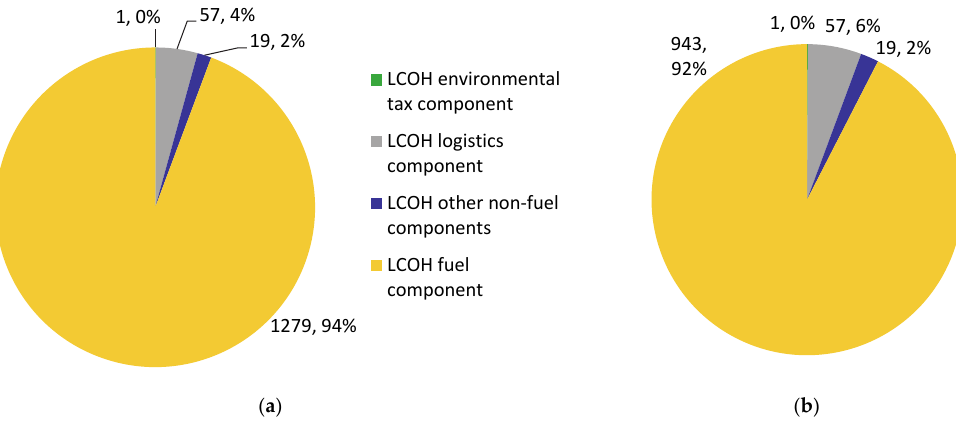
Figure 8. LCOH structure from KZOT BRS 1000 Comfort BM (1 MW) from natural gas: ( a ) January 2022; ( b ) July 2022.